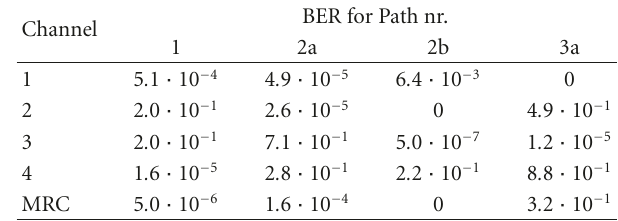
Table 5: BERs for a number of NLoS situations without diversity. Channel tracking on the input